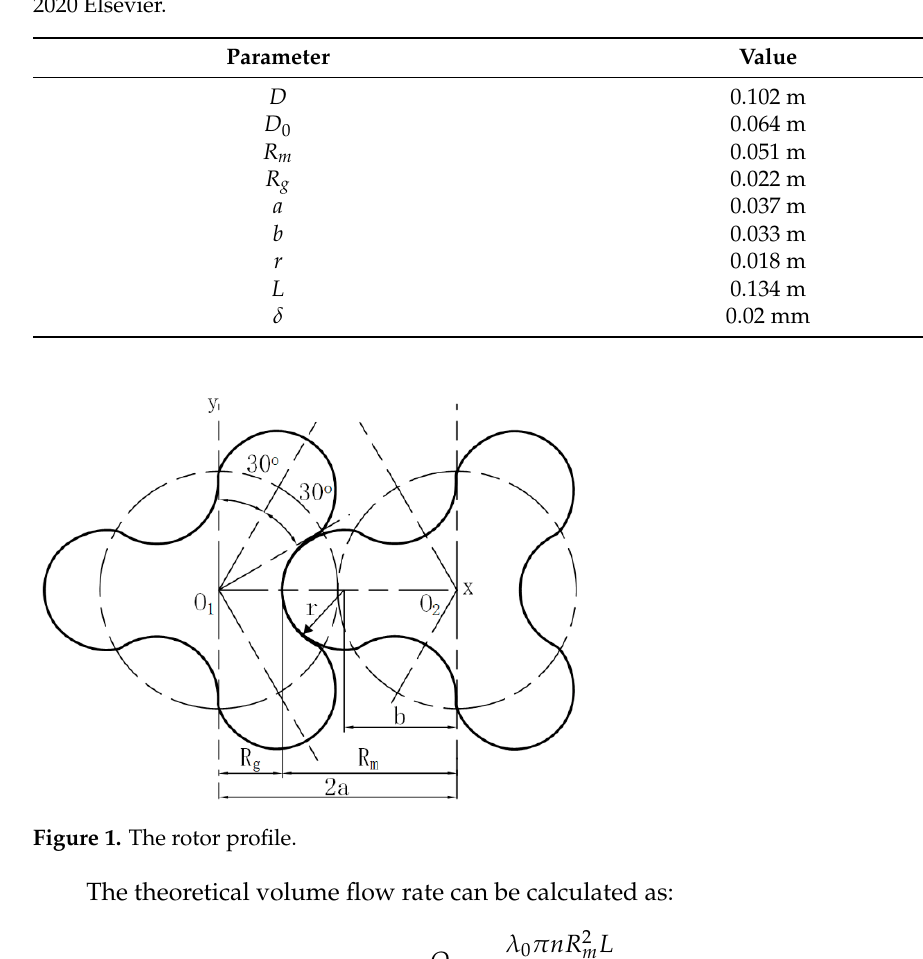
Table 1. Design parameters of the Roots pump. Reprinted with permission from ref. [7]. Copyright